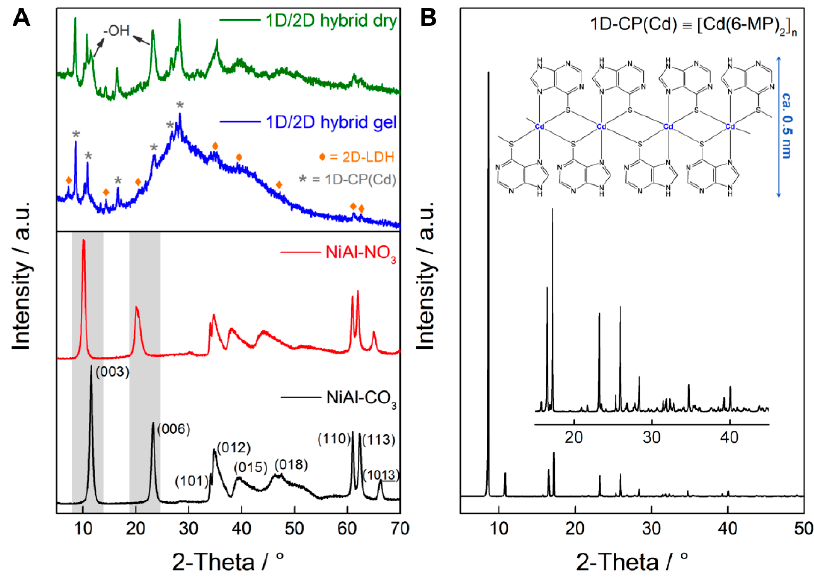
Figure 2. Powder X-ray diffraction patterns of the 1D/2D hybrid and the NiAl–LDHs ( A ) and 1D-CP(Cd) ( B ).